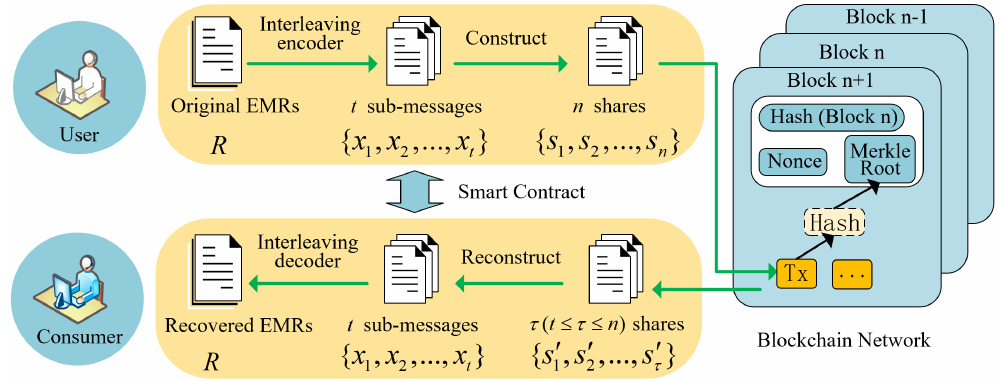
Figure 2. The framework of the lightweight privacy-preserving mechanism in the healthcare blockchain system.